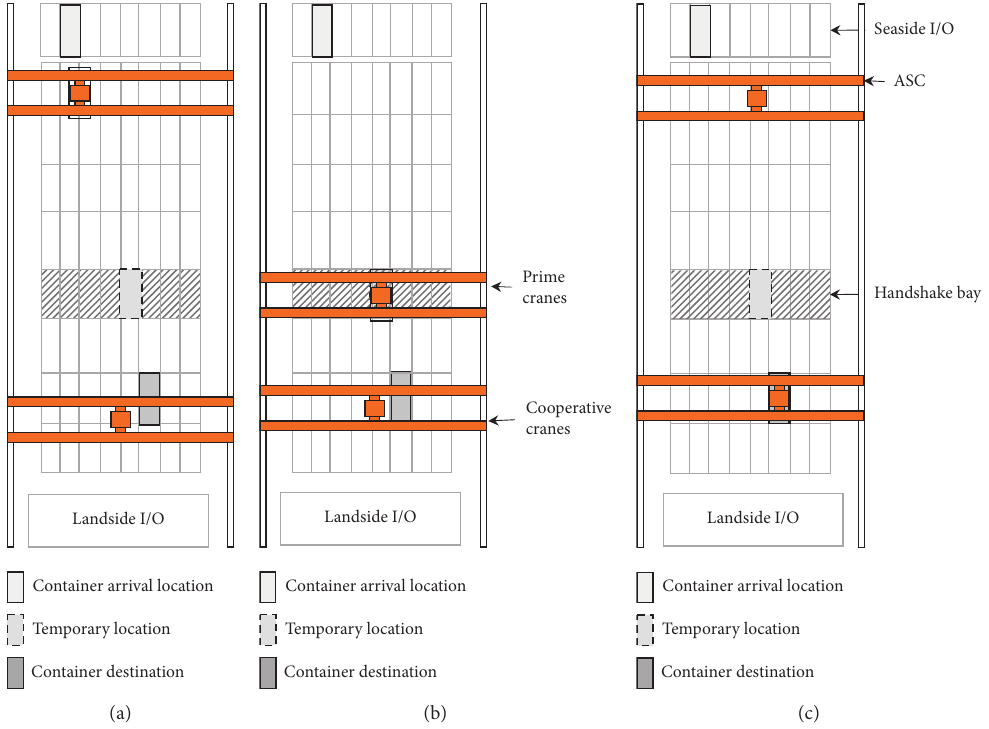
Figure 2: Twin ASCs’ operations for a storage task with handshake bay. (a) Seaside ASC picks up imported container from the I/O point. (b) Seaside ASC drops off the container at the handshake bay. (c) Landside ASC carries the container to the